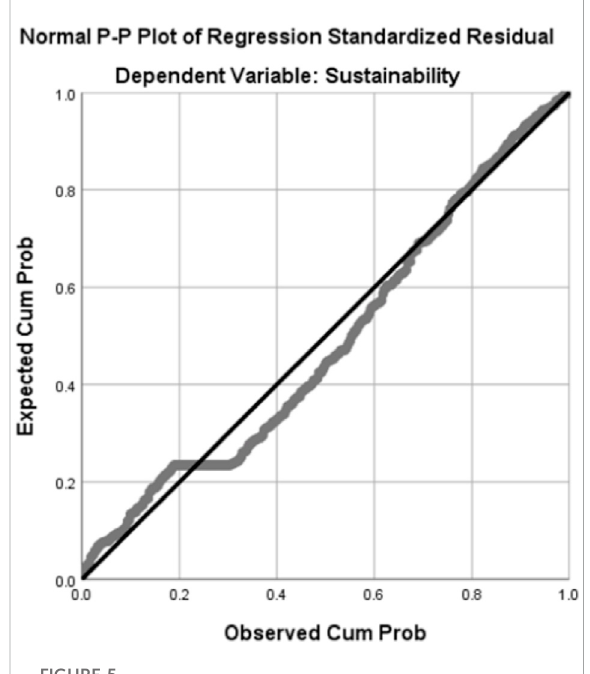
FIGURE 5 Regression ’ s P-P plot for CCD index under GC1 in the energy sector.